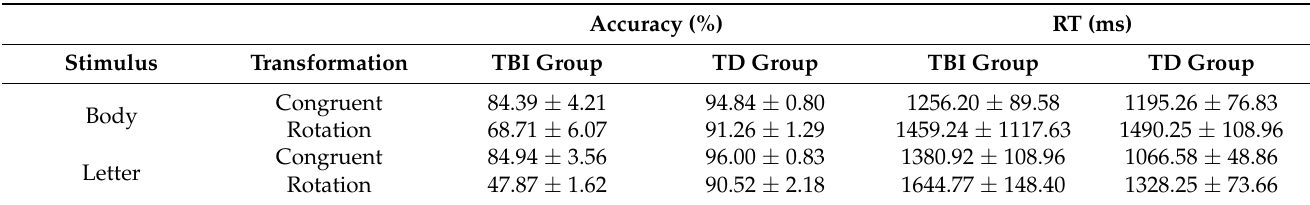
Table 3. Accuracy and Reaction Time in each condition of the Visuospatial Imagery Paradigm for the two groups.